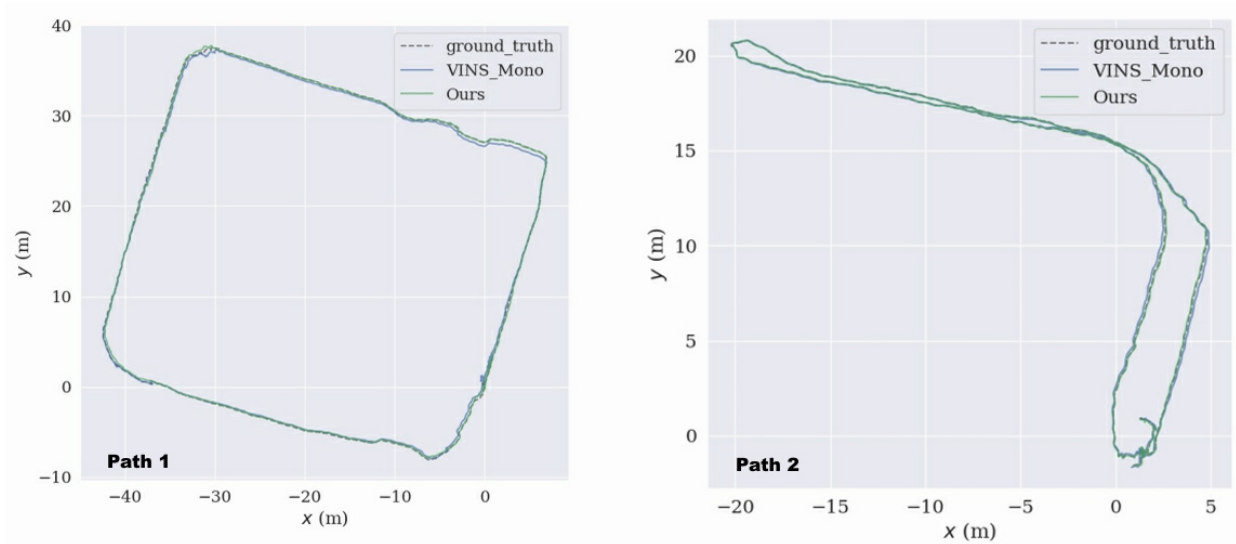
Figure 13. Scenes from coal mine tunnel.